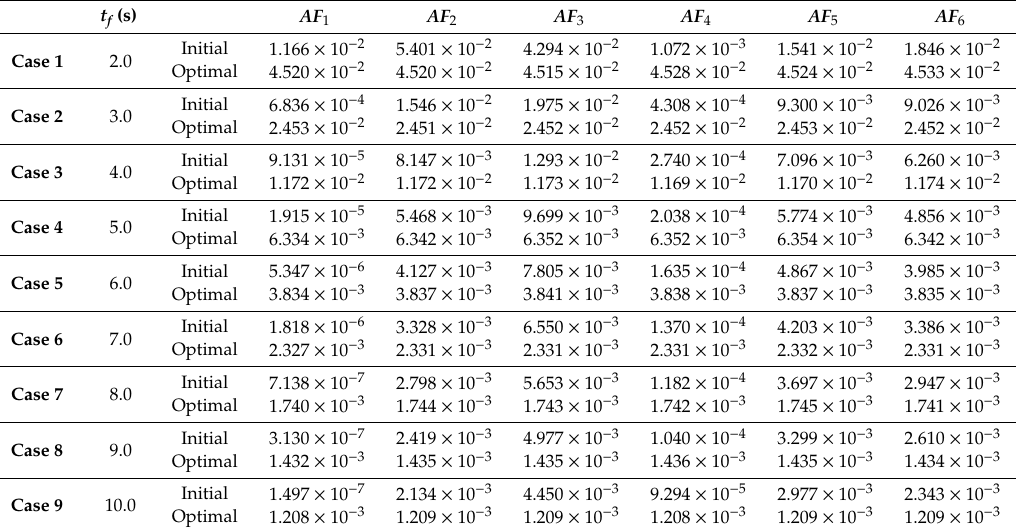
Table 6. Acceleration factors for the initial and the optimal motion.